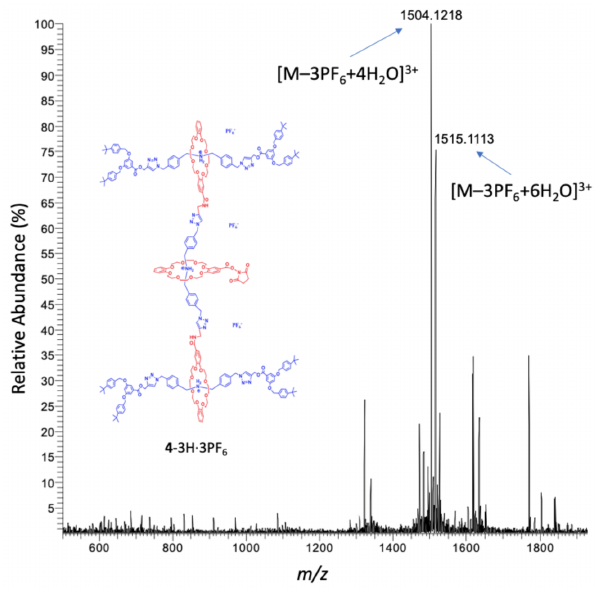
Figure 4. ESI-MS spectrum of the G2 rotaxane dendron-OSu 4 -3H · 3PF 6 . For characterization of the G2 rotaxane dendron-acetylene 5 -3H · 3PF 6 , the ESI-MS re- vealed (Figure 5) the most abundant molecular ion signal ( m / z 1483.7431) as [M–3PF 6 ] 3+ , losing its three counter-anion PF 6– , as the detectable cation species. Another molecular ion sig- nal ( m / z 1495.4098) can be attributed as the molecular ion [M–3PF 6 +2H 2 O] 3+ . Overall, water adducts to two dendrons in the gas phase were observed through mass spectrometric analyses.